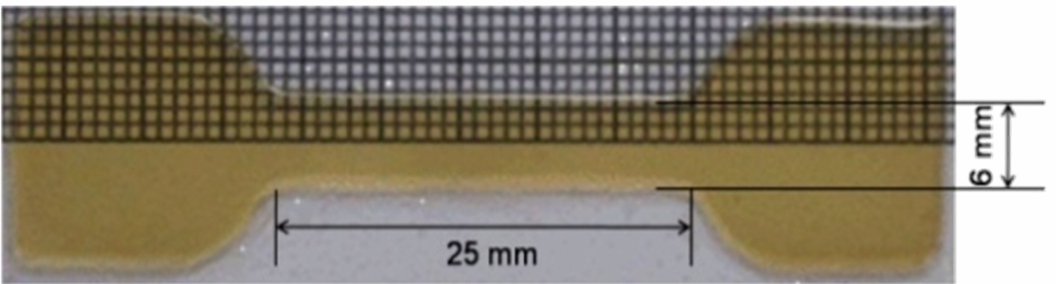
Figure 1. Optically transparent TG_20 film is used for tensile testing with dimensions according to the ASTM standards (gauge length 25 mm, width 6